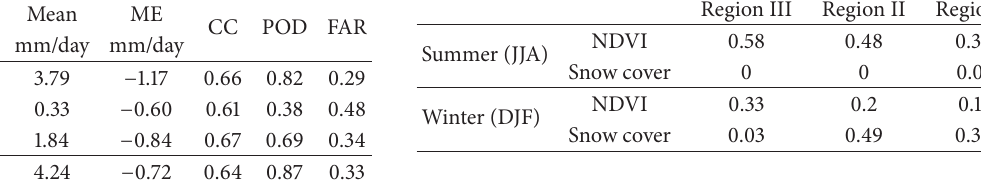
Table 5: Validation statistics comparing the performances of GSMaP rainfall estimates over high latitude regions (Region III).